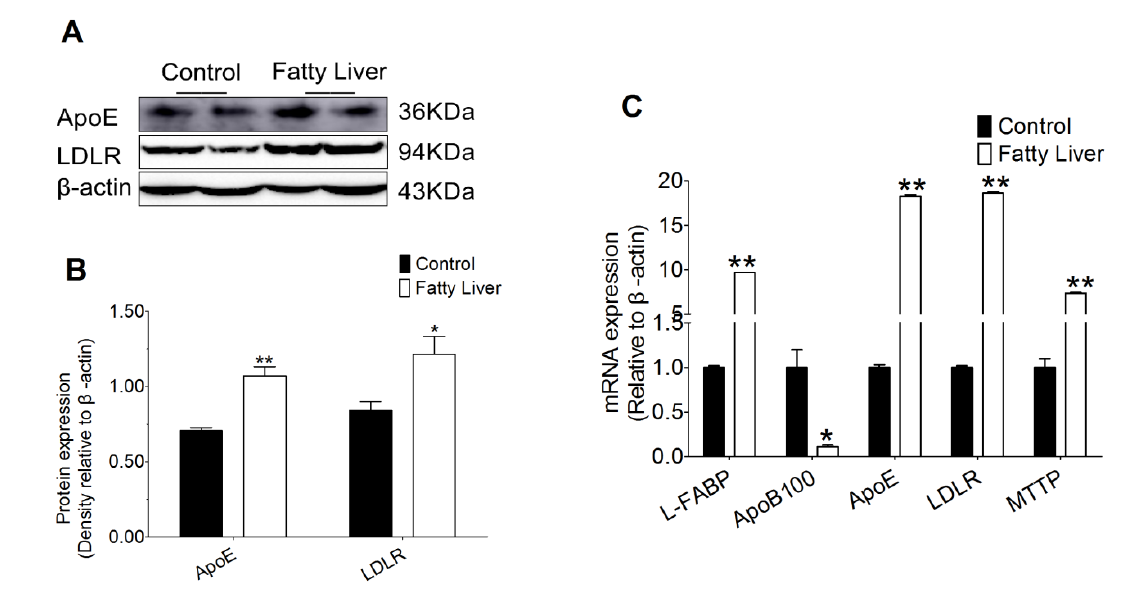
Figure 6. Lipid deposition promotes the lipid transport pathway in the cow liver. ( A , B ) Levels of the proteins apolipoprotein E (ApoE) and low density lipoprotein receptor (LDLR) in control (n = 6) and fatty liver (n = 6) group dairy cows were determined by western blotting. ( C ) Total RNA was extracted from liver samples and the expressions of the genes involved in the lipid transport pathway in control (n = 6) and fatty liver (n = 6) group dairy cows were determined by real-time RT-PCR. The data presented are the mean ± SEM. * p < 0.05; ** p < 0.01.